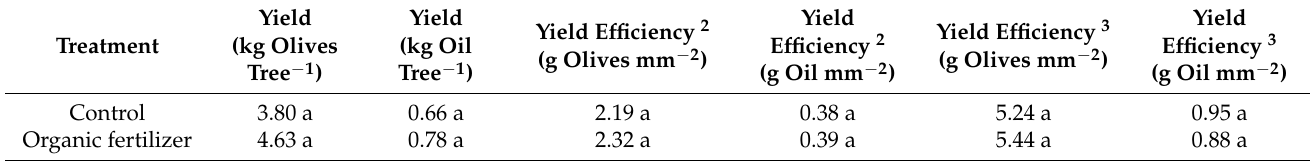
Table 1. Tree yield and yield efficiency of treated (organic fertilizer) and control (chemical fertilizer) trees in the field 1 .